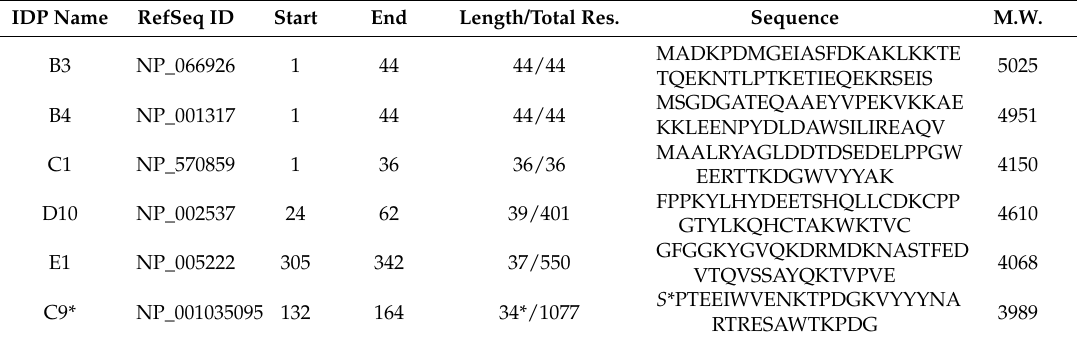
Table 1. Entry name of the intrinsically disordered protein (IDP) samples in this study, RefSeqID, start and end positions, length, total number of residues of full-length protein, amino acid sequence, and calculated molecular weights are indicated. Start and end indicate the residue numbers corresponding to the full-length protein. M.W. indicates molecular weight. Asterisk indicates an additional serine residue that was added to the N-terminus of